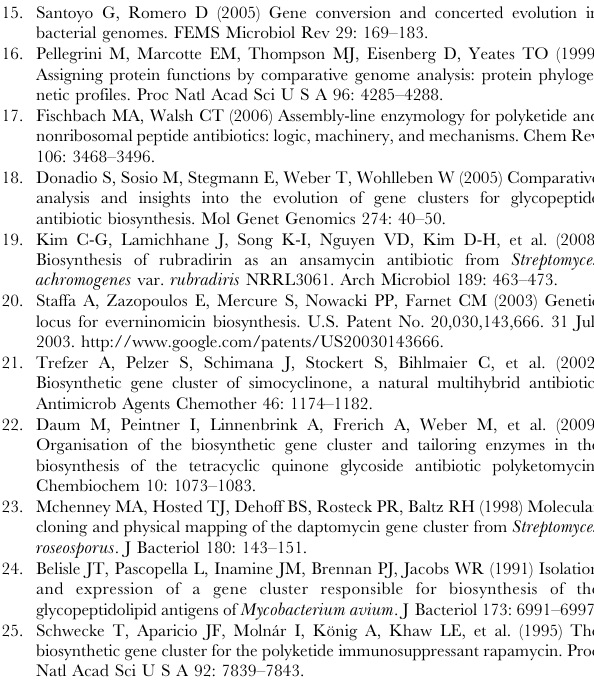
Figure S9 Clustered heat map of features based on protein sequence alignments and domain-similarity network topologies. Features include the average number of Pfam domains per gene, means and standard deviations of the clustering coefficient and the network transitivity (see Methods for more details). At least four distinct clusters of BGCs appear from the heat map that have different evolutionary characteristics. Figure S10 Domain architectures of all 658 BGCs encoding multimodular PKS and NRPS enzymes. The domains are colored by the p-value of the homology to their nearest neighbor within the same gene cluster. BGCs that are mostly red contain domains that are highly similar to other domains in the same gene cluster, whereas BGCs that are mostly blue contain domains that are dissimilar from other domains within the same gene cluster. Figure S11 Detailed phylogenetic trees of KS and AT domains of polyketide synthases from the rapamycin family. The tree was reconstructed using the neighbor-joining method in MEGA [72], using 100 bootstrap replicates. Table S1 Overview of evolutionary events detected between alignments of gene cluster pairs sharing at least three matching 1 kb-sized blocks in alignments with thresholds of . 70% identity (top) or . 80% identity (bottom). The numbers of observed indels, duplications and